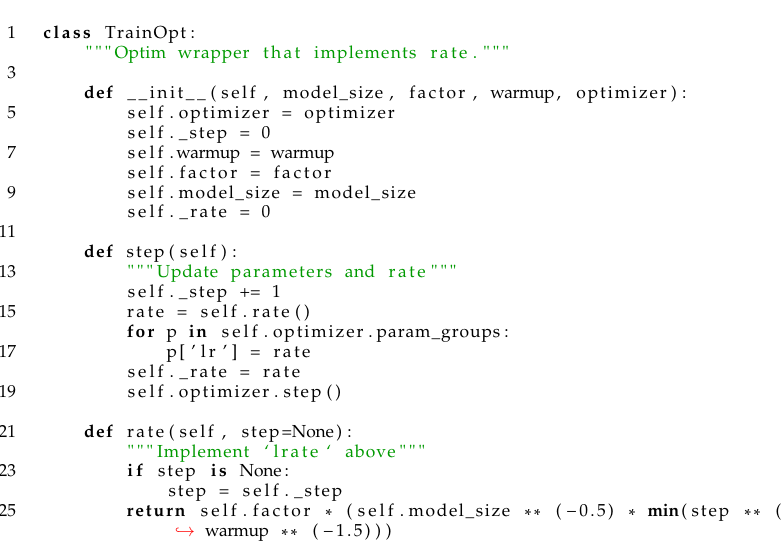
Figure 4. The implementation of the training optimizer.